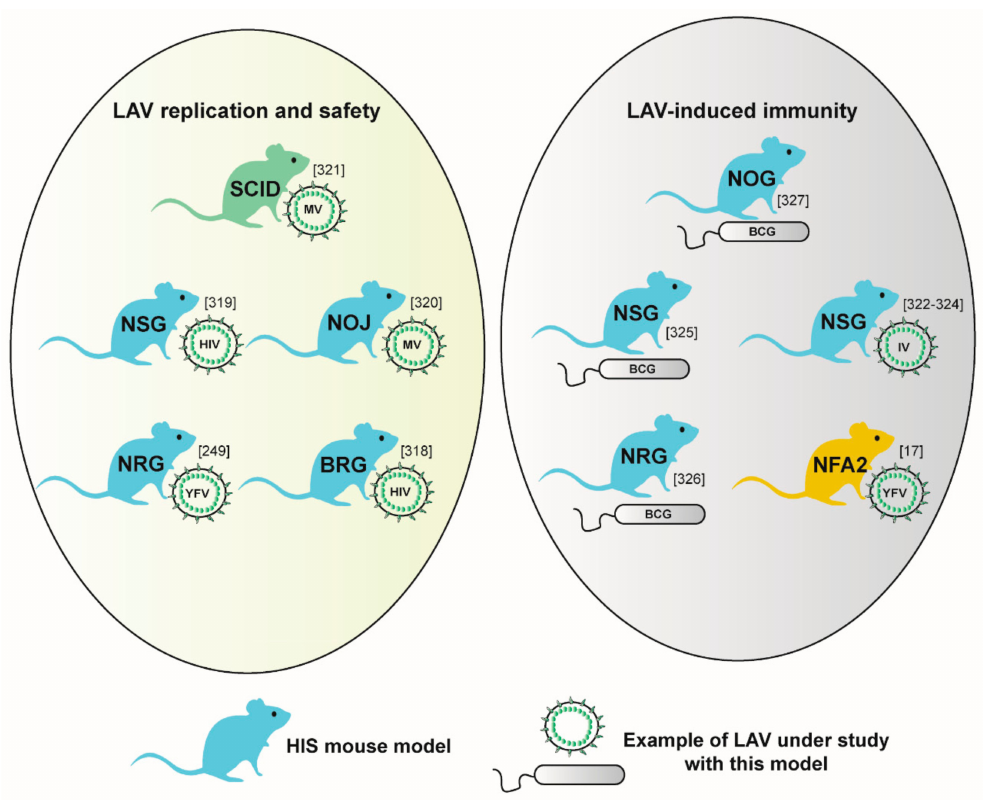
Figure 2. Use of human immune system mice for live-attenuated virus research. Schematic representation of the past contributions of human immune system mice (HIS mice) to investigate live-attenuated vaccines (LAV) replication and safety (left) and LAV-induced immunity (right). Each model is defined by its acronym and is color-coded similarly to Figure 1. LAVs are associated with the model they have been investigated with, and are codenamed as follows: MV, live-attenuated measles virus; HIV, live-attenuated human immunodeficiency virus; YFV, live-attenuated yellow fever virus; IV, live-attenuated influenza virus; BCG, Tuberculosis Bacille Calmette-Gu é rin vaccine. For each model and LAV, a reference number (# under bracket) connecting with the associated literature is indicated. BRG , BALB-c-RAG2 − / − IL2R γ null ; NFA2, NRG - Flk2 − / − HLA-A2*0201 tg ; NOG , NOD / shi-SCID-IL2R γ null ; NOJ, NOD-SCID JAK 3null ; NRG , NOD- RAG1 − / − IL2R γ null ; NSG, NOD / LtSz-SCID-IL2R γ null ; SCID, severe combined